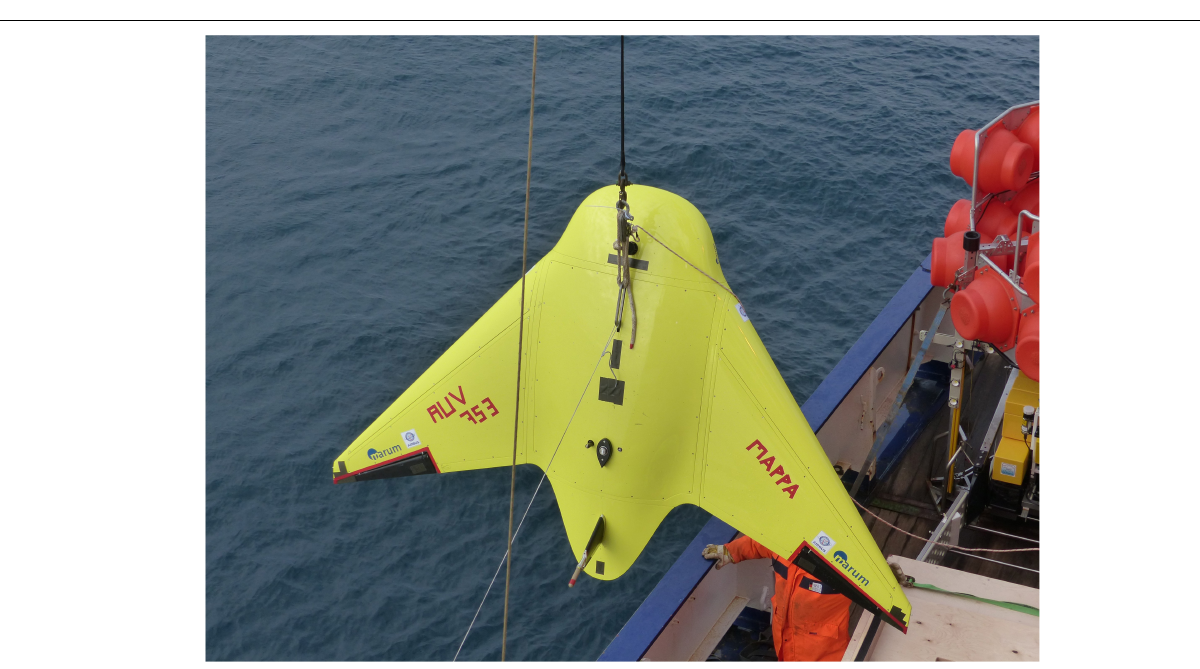
are many months. Wynn et al. (2014) and Vedachalam et